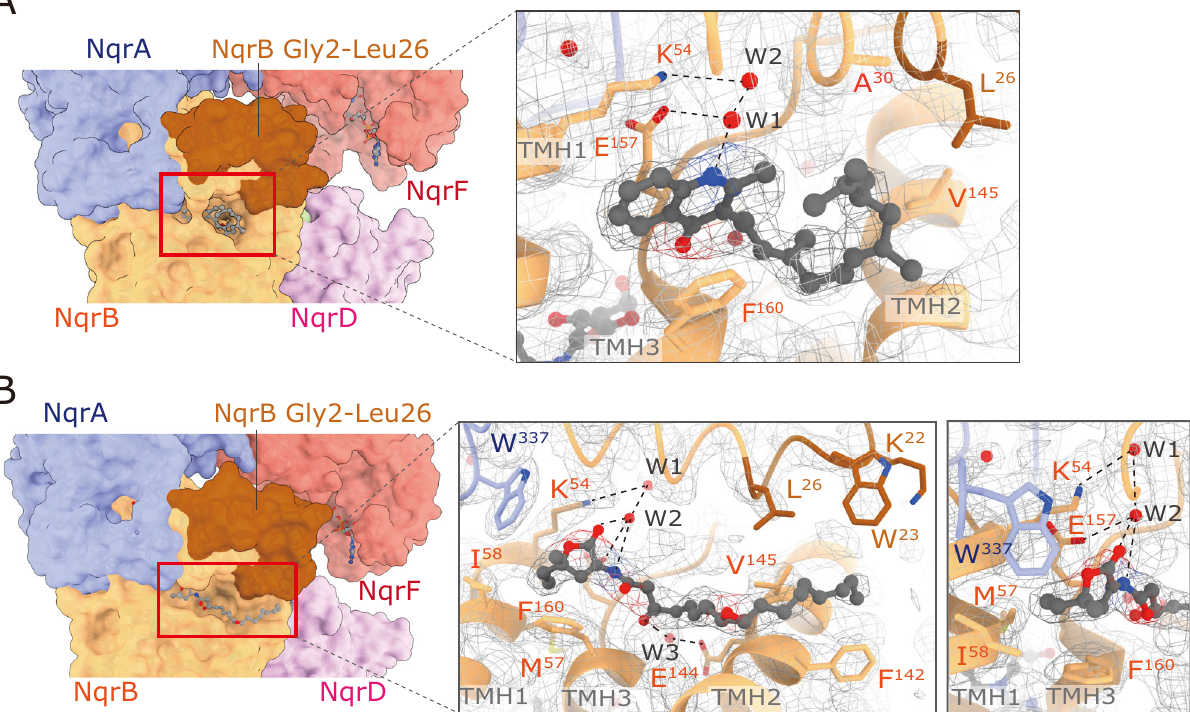
Fig. 6 Structures of Na + -NQR with bound inhibitors. Aurachin D-42 ( A ) and korormicin A ( B ) bind to the N-terminal region starting with TMH 1 of NqrB. Left and right panels show the overall and enlarged views of the binding pockets, respectively. The residues that are involved in the interaction with the inhibitors are indicated as sticks model. The density maps are shown as mesh representations. The disordered region (NqrB-Gly2 – Leu26) in the absence of an inhibitor is indicated in dark brown (a left panel). The possible hydrogen bonds are represented as dashed lines . Water molecules are shown as red spheres